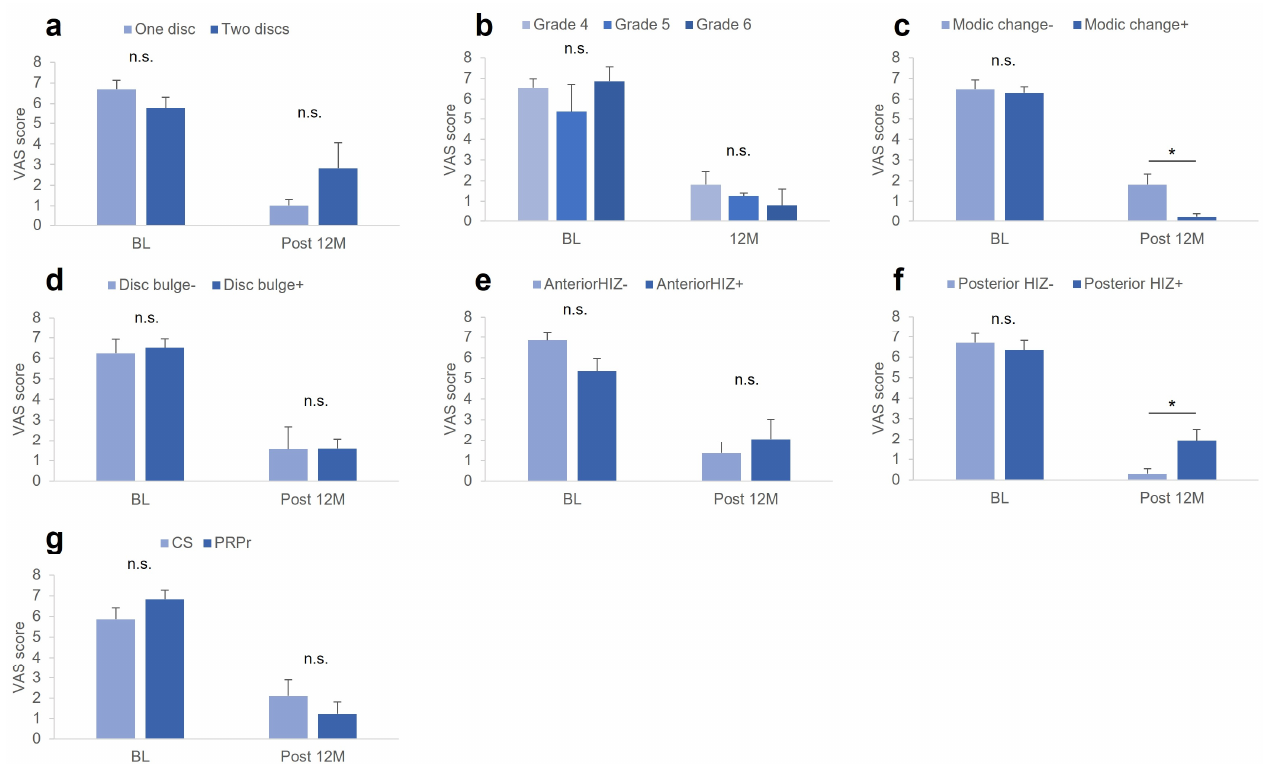
Figure 2. VAS at baseline and Post 12 M. VAS scores at baseline and Post 12 M among the groups classified by image characteristics of the targeted discs, including ( a ) number of targeted discs, ( b ) modified Pfirrmann grading, ( c ) Modic changes, ( d ) disc bulge, ( e ) anterior HIZ, ( f ) posterior HIZs, and ( g ) treatment group. VAS, visual analog scale; CS, corticosteroid; PRPr, platelet-rich plasma releasate; HIZ, high-intensity zone. * p < 0.05 between the groups. The change in VAS score was significantly lower in patients with posterior HIZs than in those without posterior HIZs ( p < 0.05, Table 2). The % change in VAS was significantly lower in patients with 2 targeted discs compared to those without 2 targeted discs, signif- icantly lower in patients without Modic changes compared to those with Modic changes, and significantly lower in patients with posterior HIZs compared to those without poste- rior HIZs (all p < 0.05; Table 2). Segmental angulation or LL angle at baseline showed no significant correlations with VAS at Post 12 M, change in VAS, or % change in VAS. Table 2. Factors associated with VAS